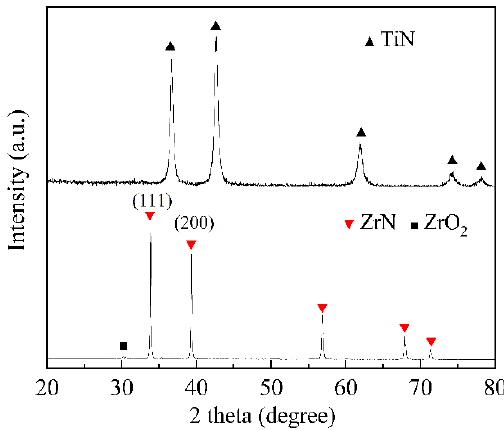
Figure 1. XRD patterns of raw ZrN powders and TiN powders.